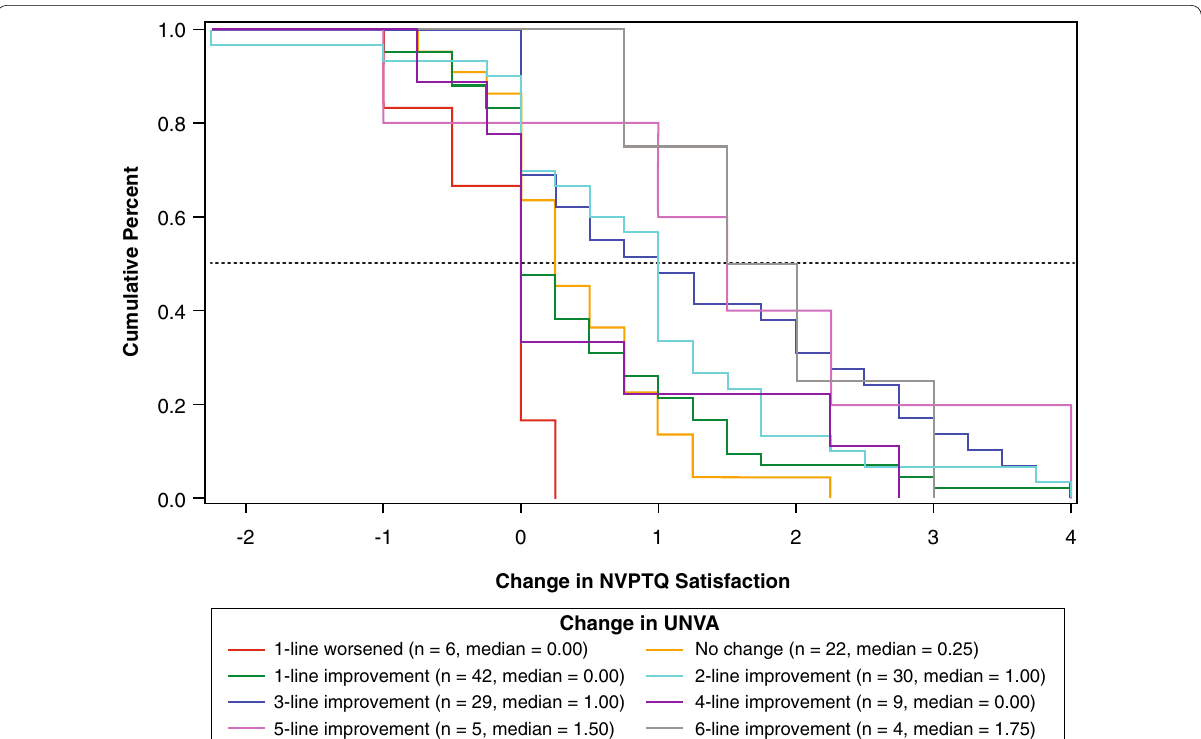
Fig. 9 eCDF of change in NVPTQ Satisfaction by change in UNVA. Note Change is computed as Day 28 Hour 1 minus Day 1 Hour 0. Positive scores indicate improvement. eCDF, empirical cumulative distribution; NVPTQ, Near Vision Presbyopia Task-based Questionnaire; UNVA, uncorrected near visual